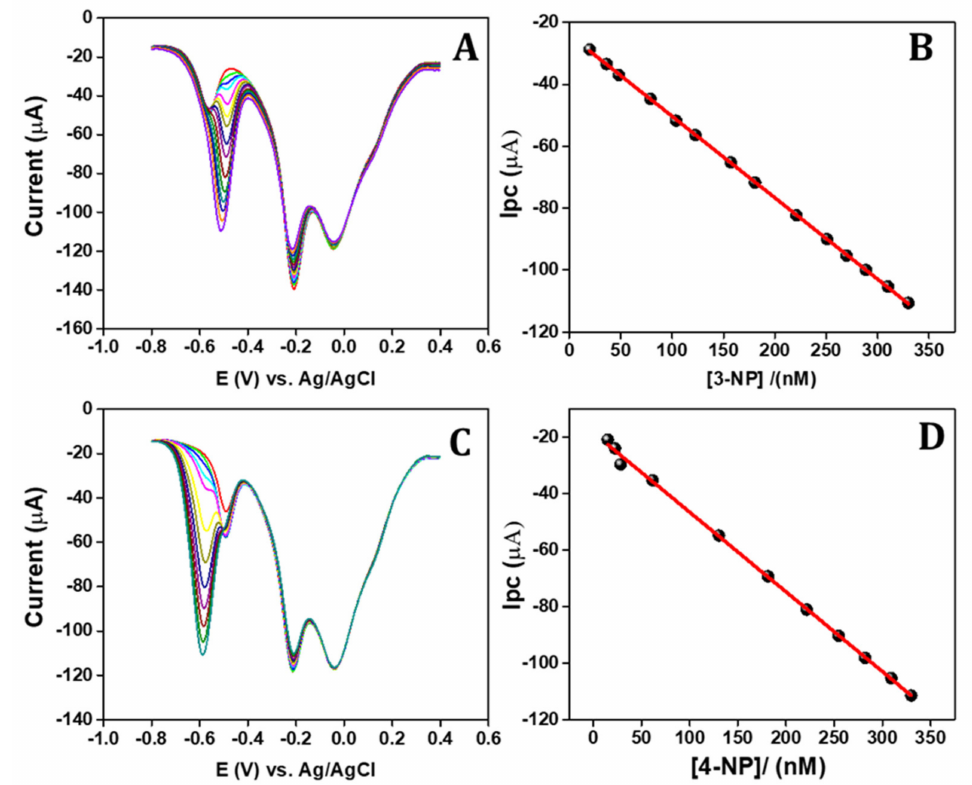
Figure 5. ( A ) DPV response of the APGE/PTH in different concentrations of 3-NP in the presence of 20 nM of 4-NP; ( B ) 3-NP concentration vs. cathodic peak current calibration plot; ( C ) DPV response of 4-NP at different concentrations in the presence of 20 nM of 3-NP; and ( D ) 4-NP concentration vs. cathodic peak current calibration